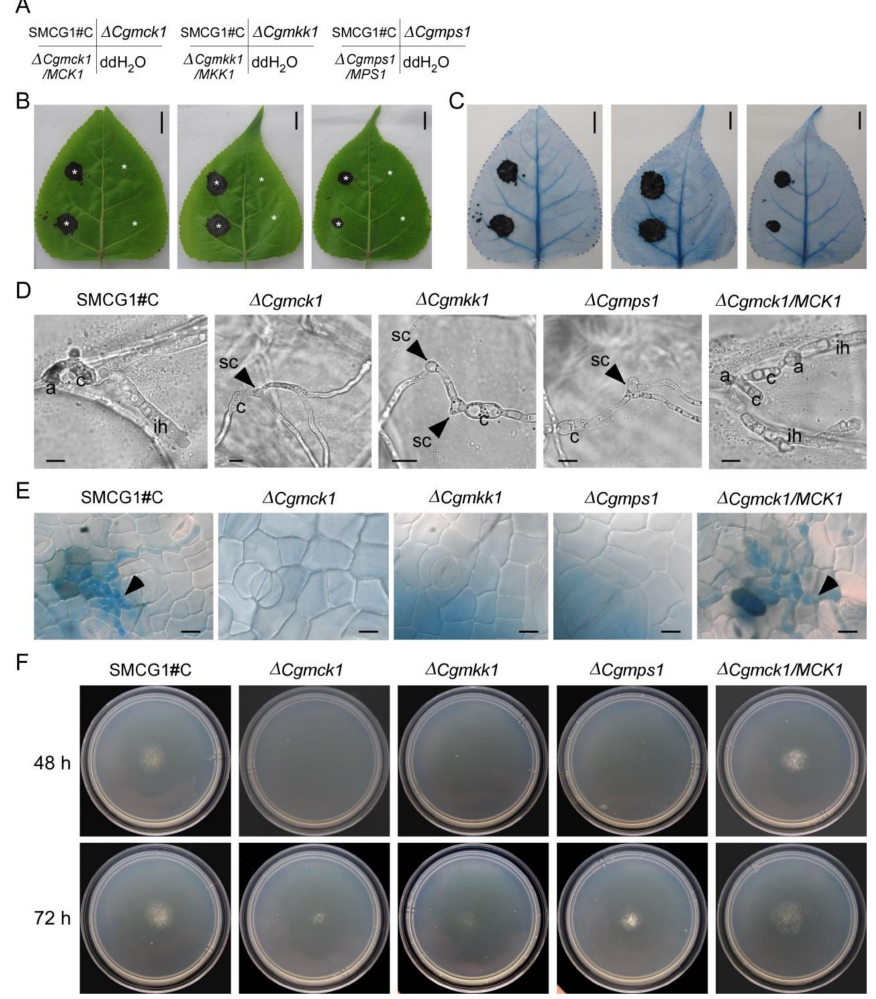
Figure 6. CgMck1 involving in penetration structures development. ( A ) The conidial suspension inoculation position of the wild type SMCG1#C, ∆ Cgmck1 , ∆ Cgmkk1 , ∆ Cgmps1 and the complemented strains in picture B and C was indicated. ( B ) Lesions developed on the unwounded detached leaves of poplar inoculated by the wild type SMCG1#C, ∆ Cgmck1 , ∆ Cgmkk1 , ∆ Cgmps1 and the complemented strain ∆ Cgmck1 / MCK1 . Stars indicate inoculation sites. Photographs were taken five days after inoculation. Scale bars = 10 mm. ( C ) Trypan blue staining of lesions in picture B. Scale bars = 10 mm. ( D ) Invasive hyphae of the wild type SMCG1#C, ∆ Cgmck1 , ∆ Cgmkk1 , ∆ Cgmps1 and the complemented strain ∆ Cgmck1 / MCK1 developed on the onion epidermic cells. Appressoria, conidia and invasive hyphae, swollen cells were indicated by a, c, ih, and sc, respectively. Scale bars = 10 µ m. ( E ) Invasive hyphae developed in the poplar leaves in vivo stained by trypan blue. Photographs were taken 12 h after inoculation. Scale bars = 10 µ m. Arrows indicated invasive hyphae. ( F ) Penetration ability of the tested on cellophane sheets. Colonies grown for 48 h and 72 h on a CM medium plate covered by a cellophane sheet, and the colony in the same plate with cellophane removal and incubated for one additional day, respectively. ddH 2 O: double distilled